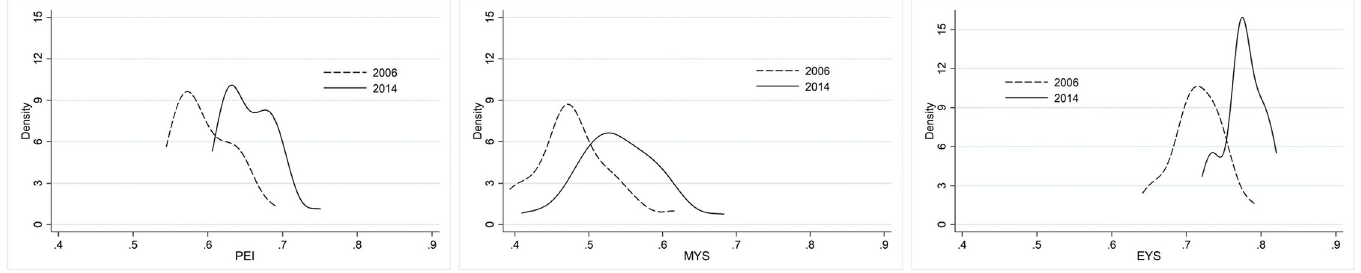
Fig 2. Distribution of the Provincial-level Education Index and its components. Notes: Each line represents the density function of the corresponding distribution. MYS = mean years of schooling index; EYS = expected years of schooling index: PEI = Provincial-level Education Index.